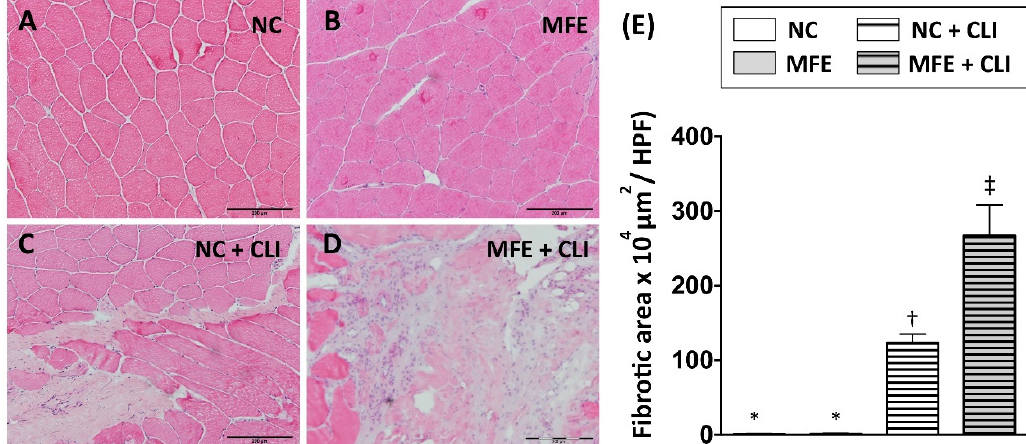
Figure 5. Maternal fructose exposure increased the fibrotic area in ischemic quadriceps after induction of critical limb ischemia. ( A ) Hematoxylin and eosin (H&E) staining for quadriceps. ( B ) Quantitation and calculation of the fibrotic area in the quadriceps. In normal conditions, no fibrotic area was found in quadriceps in both NC and MFE group. However, by 14 days after induction of CLI, the fibrotic area in MFE group was significantly higher than that in the NC group. NC, normal control; MFE, maternal fructose exposure; CLI, critical limb ischemia. Scale bar in the lower-right corner indicates 200 µ m. Error bars represent the standard deviation (SD). Groups with di ff erent symbols (*, † , ‡ ), p < 0.05. n = 8 for each group.